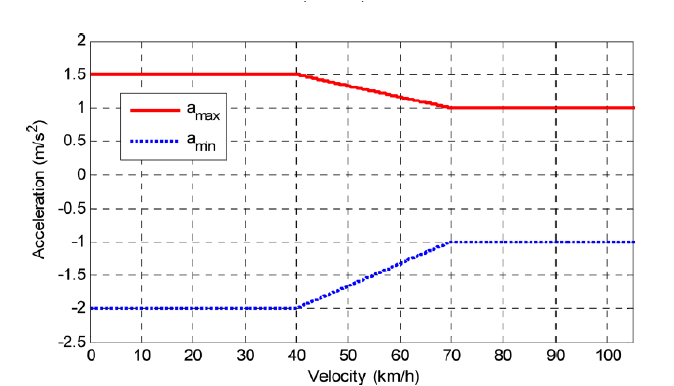
Figure A1. Velocity-dependent range of longitudinal